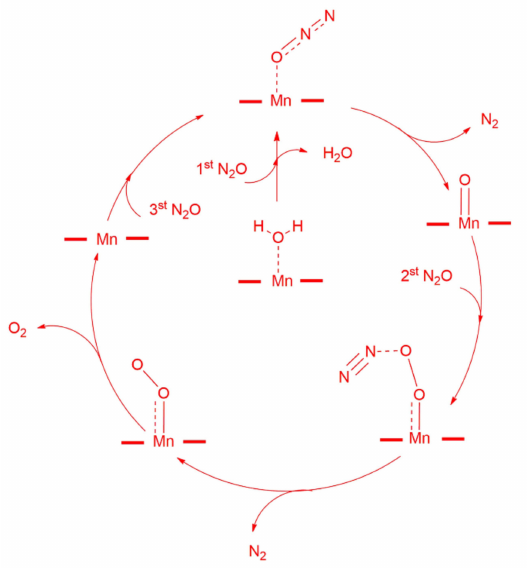
Figure 2. Single-site mechanism of N 2 O decomposition [63]. Copyright 2017,